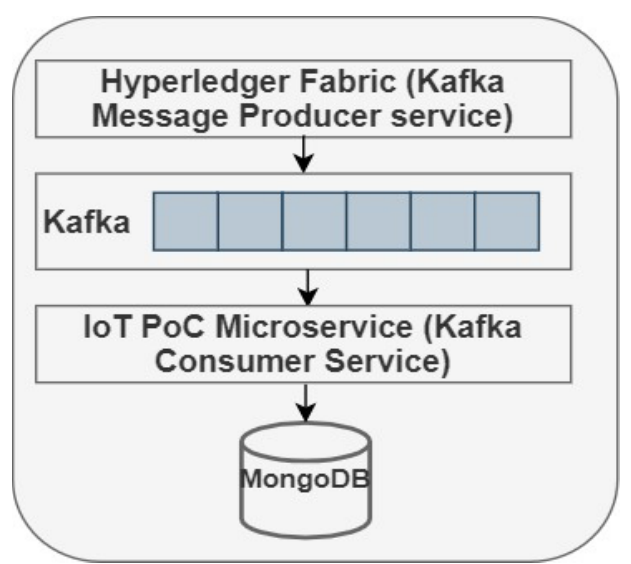
Figure 4. Interaction between Fabric, Kafka, and Microservice.